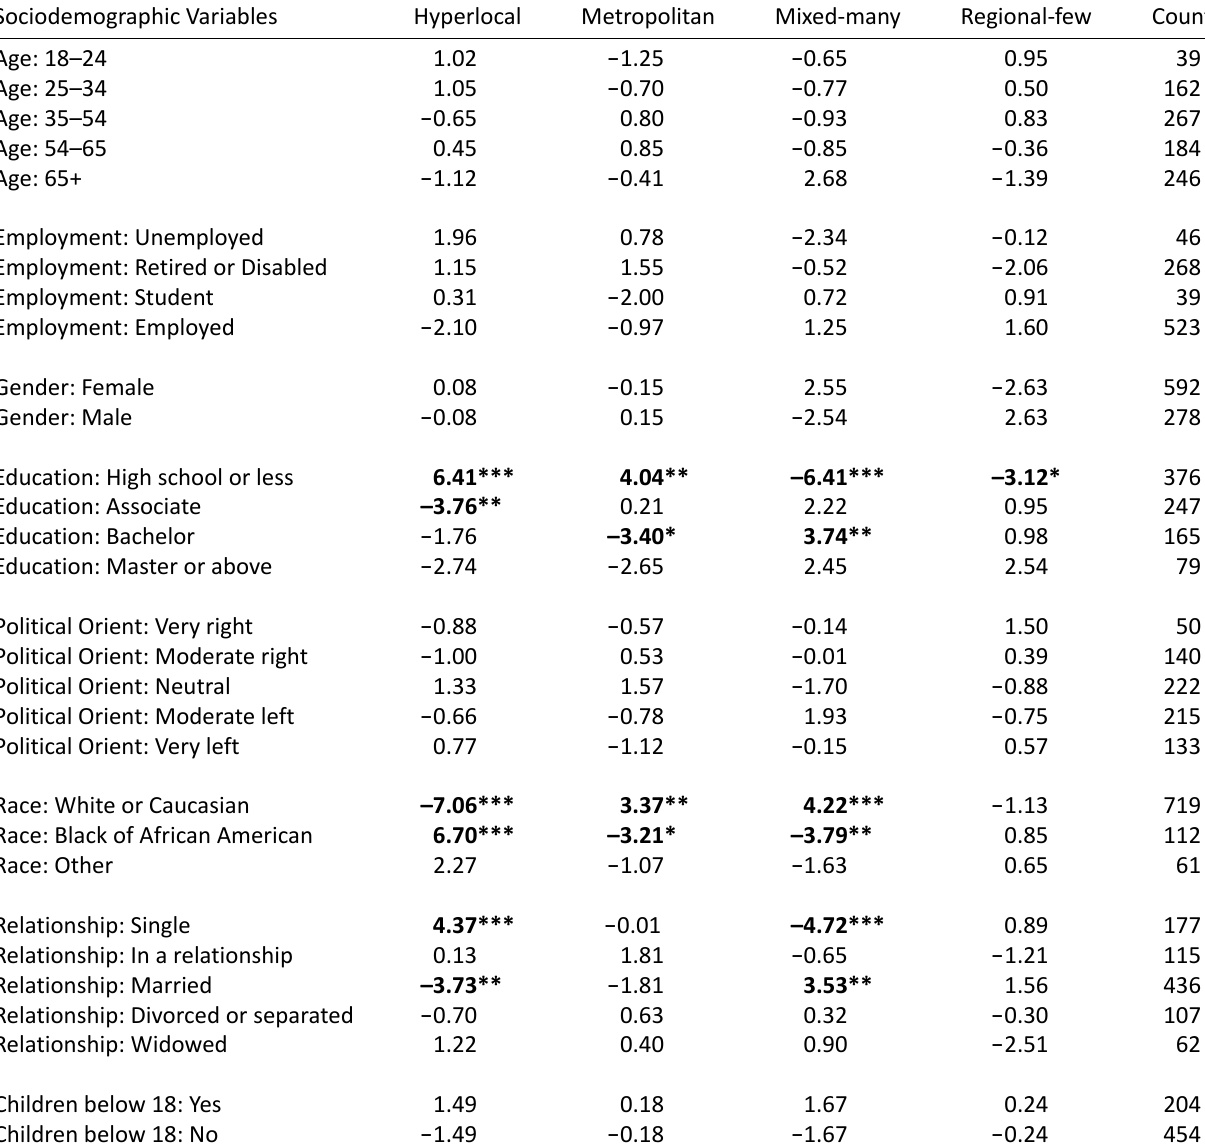
Table 1. Standardized residuals from Chi‐square post‐hoc